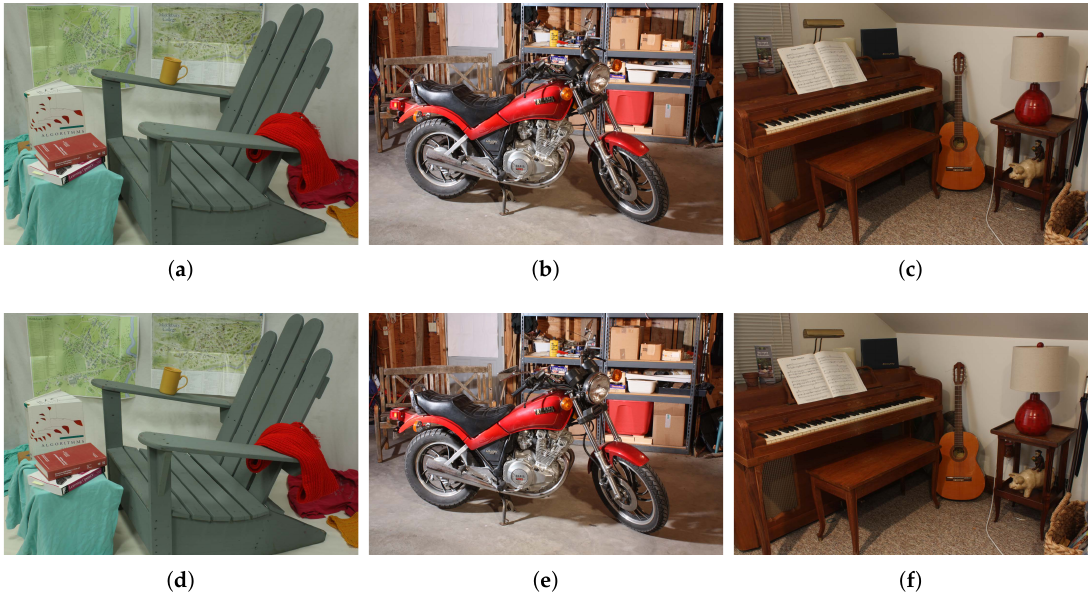
Figure 11. ( a – c ) Original ‘Adirondack’, ‘motorcycle’ and ‘piano’; ( d – f ) watermarked ‘Adirondack’, ‘motorcycle’ and ‘piano’ by the proposed method.